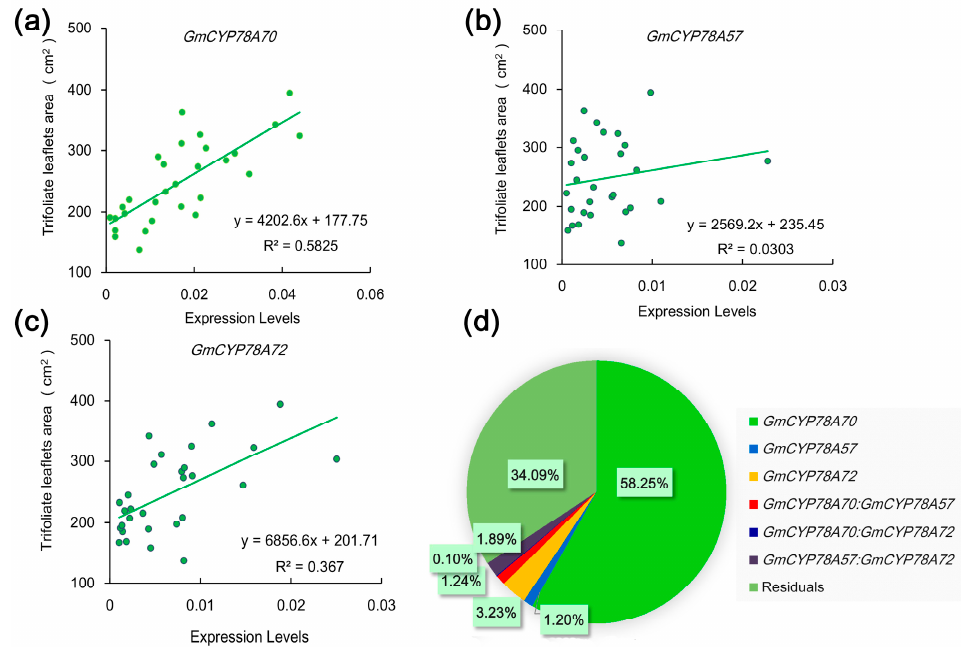
Figure 5. Relationships between the leaf area and the expression level of GmCYP78A s in leaves. ( a – c ) Linear regressions between the leaf areas and the expression levels of GmCYP78A70 , GmCYP78A57 and GmCYP78A72 , respectively. Data shown are mean ± SE ( n = 3). ( d ) The respective contribution of GmCYP78A s expression to leaf area (percentage of variation explained). For the statistical analysis of relationship between gene expression level and trait, a linear model was fitted with the R function lm. The model was fitted with the following terms: “trait ~ GmCYP78A70 + GmCYP78A57 + GmCYP78A72 + GmCYP78A70:GmCYP78A57 + GmCYP78A70:GmCYP78A72 + GmCYP78A57:GmCYP78A72”, where the individual effect of each gene and the interaction effects of gene pairs were included.